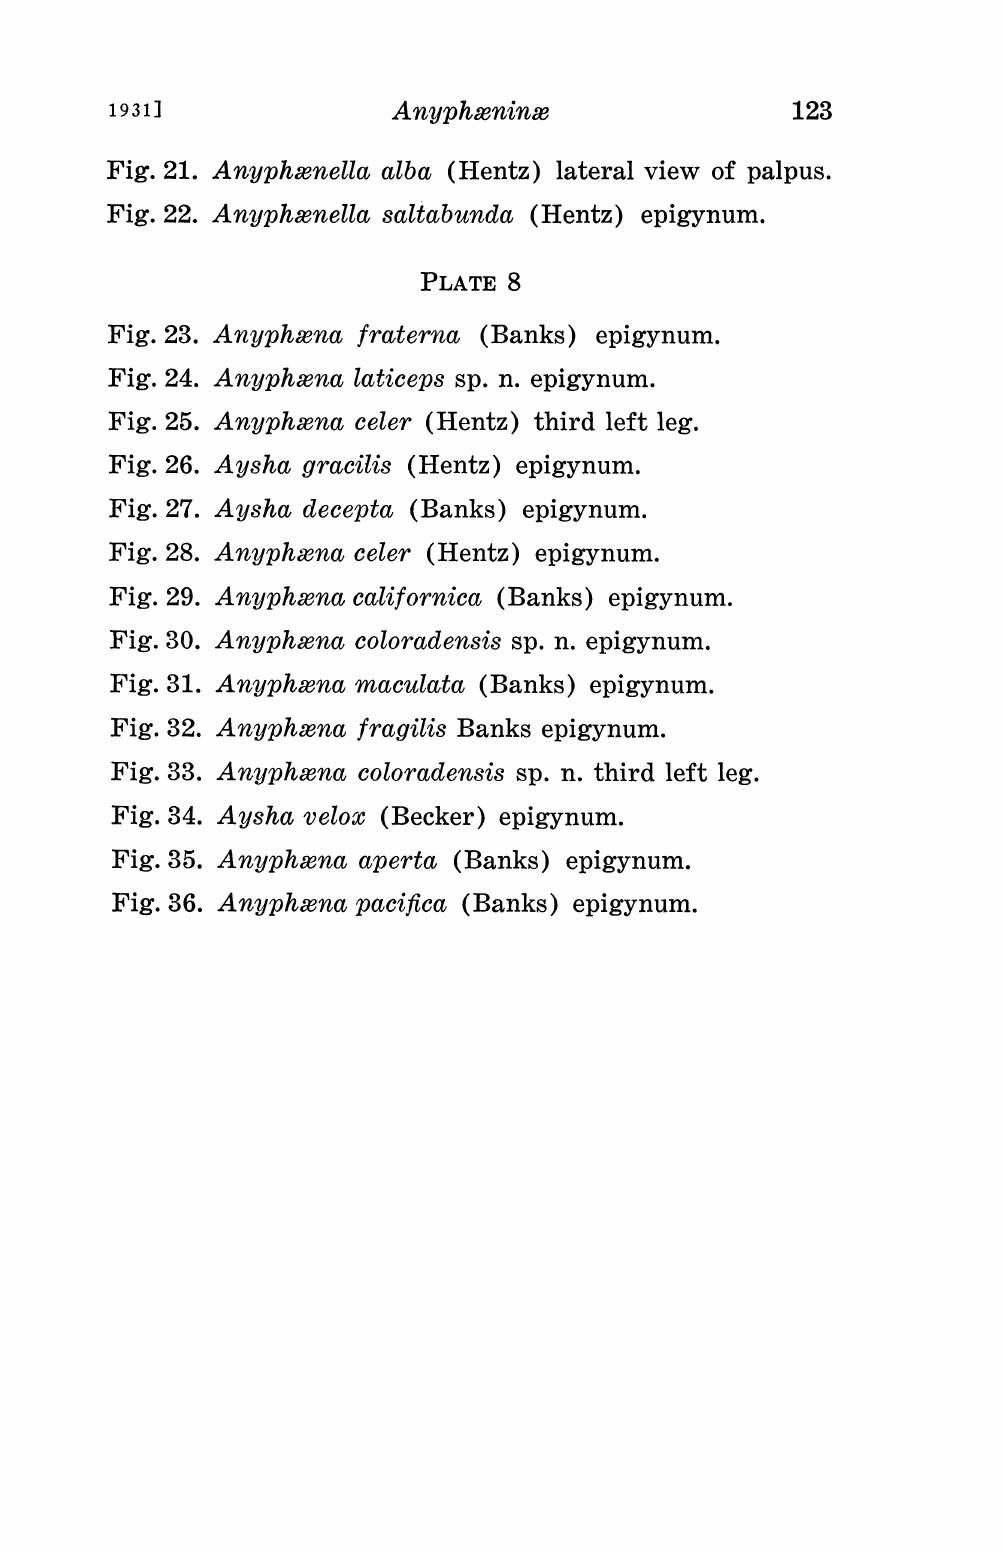
Fig. 23. Fig. 24. Fig. 25. Fig. 26. Fig. 27. Fig. 28. Fig. 29. Fig. 30. Fig. 31. Fig. 32. Fig. 33. Fig. 34. Aysha velox (Becker) epigynum. Fig. 35. Anyphxna aperta (Banks) epigynum. Fig. 36. Anyphxna pacifica (Banks)